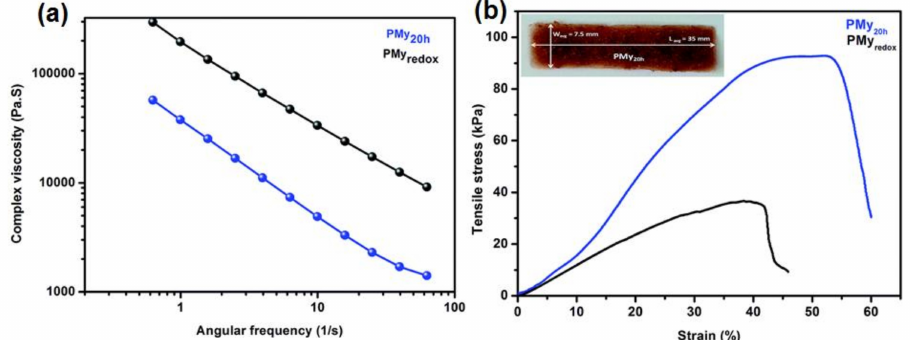
Figure 5. ( a ) Plot of complex viscosity versus angular frequency polymyrcene, ( b ) tensile stress-strain plot of synthesized polymyrcene. Sample designations: ‘PMy 20h ’ stands for polymyrcene via persulfate polymerization, and ‘PMy redox ’ stands for polymyrcene via redox polymerization. (Reproduced from Reference 19, with permission from The Royal Society of Chemistry).